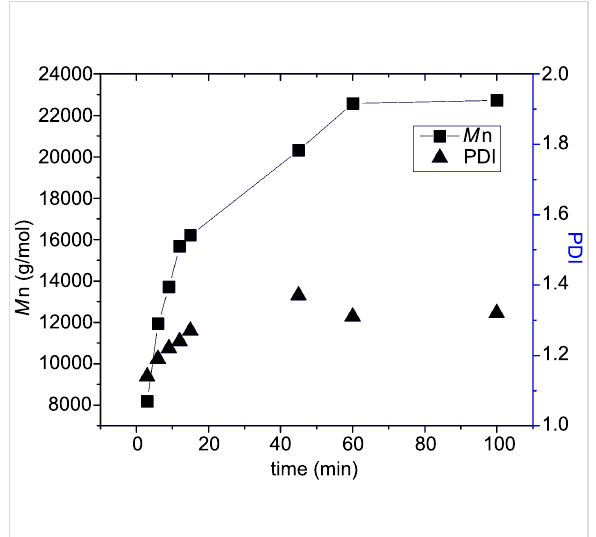
Figure 6: M n vs. time ( t ) kinetic plot and M w / M n (PDI) of the polymeriz- ation of monomer T 9 with catalyst U3 ; [ 9 ]/[ U3 ] = 50/1.